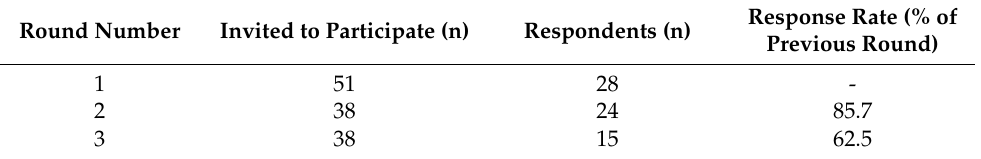
Table 1. The number of experts that were invited to participate in each of the three rounds, the size of the resulting Delphi panel and the response rate as a percentage of the previous round